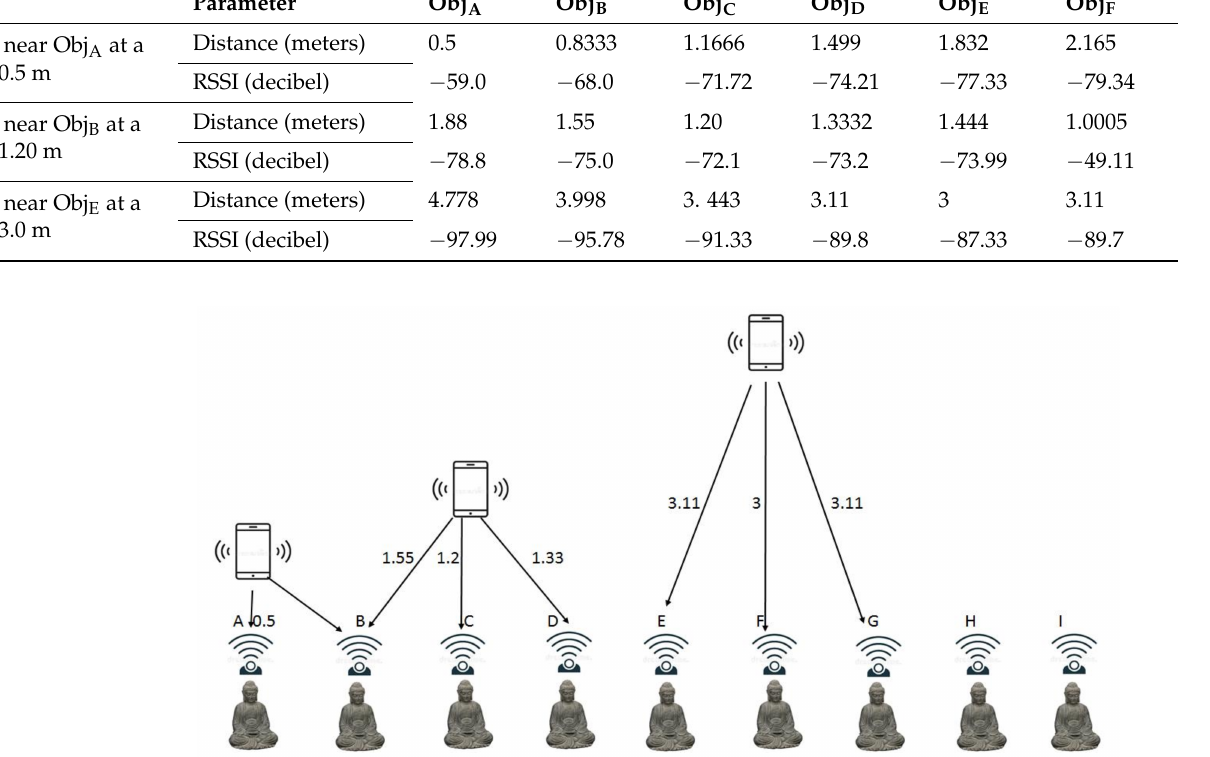
Figure 6. Determining the location and distances with three different